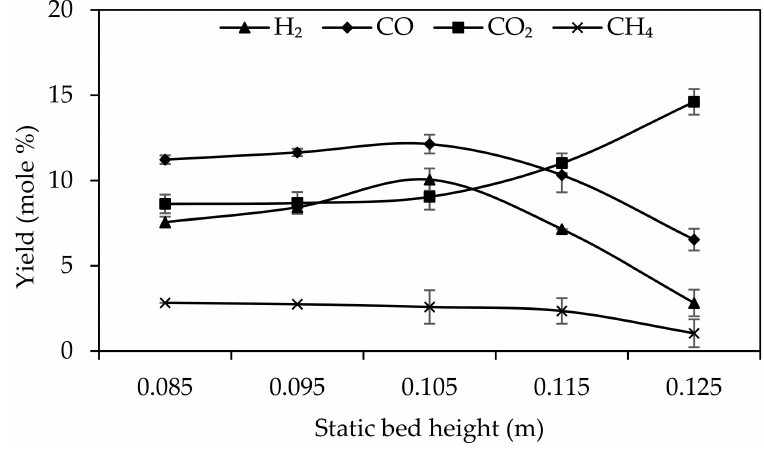
Figure 8. The e ff ect of static bed height (SBH) on syngas